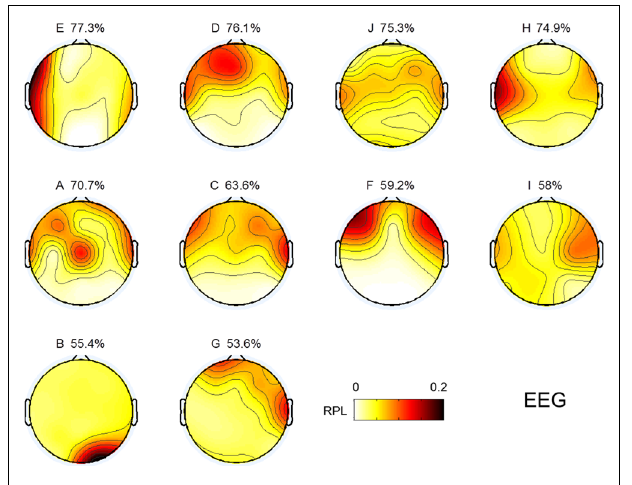
FIGURE 7 |Topographic images for resting state gamma in EEG. Images are sorted in descending order of MI performance with